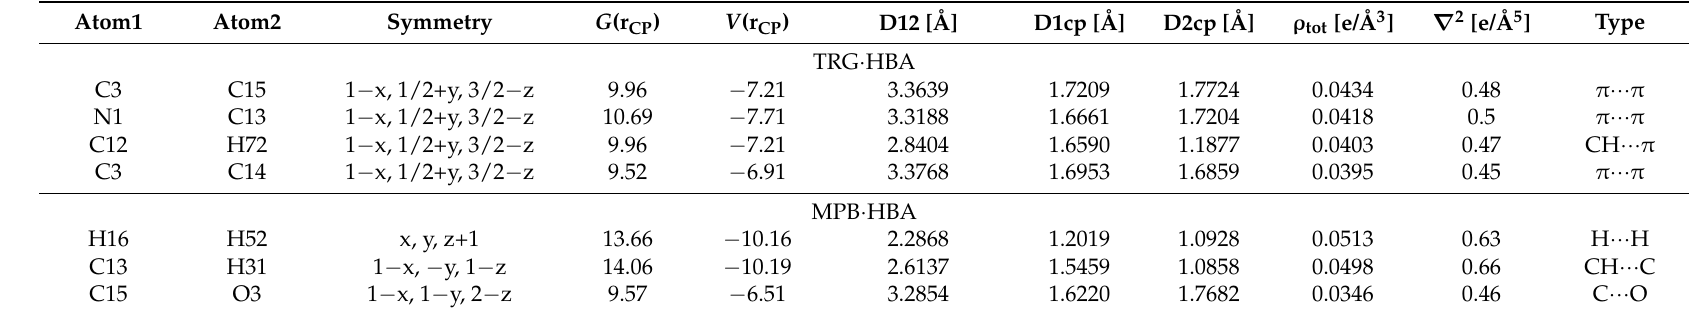
Table 3. Distances and topological characteristic of the BCPs in 1 and 2